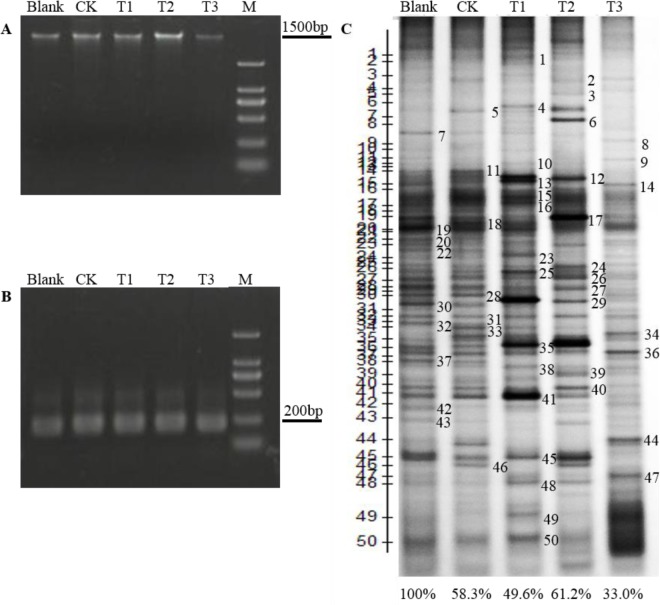
The identification of the rhizosphere microbial community under various treatments.(A), agarose gel (2%) electrophoresis of rhizosphere genomic DNA (Marker: DL2000). (B), agarose gel (2%) electrophoresis of PCR amplified 16S rDNA (Marker: DL2000). (C), PCR-DGGE (denaturing gradient gel electrophoresis) DNA profiles, and the sequencing codes for cloning of bands that differed between treatments. Abbreviation: Blank (blank plots transplanting the plant before), CK (500 mL water), T1 (apple fruit fermentation (AFF) 500 times solution), T2 (AFF 500 times solution + 108 cfu/mL Bacillus licheniformis), T3 (108 cfu/mL Bacillus licheniformis).